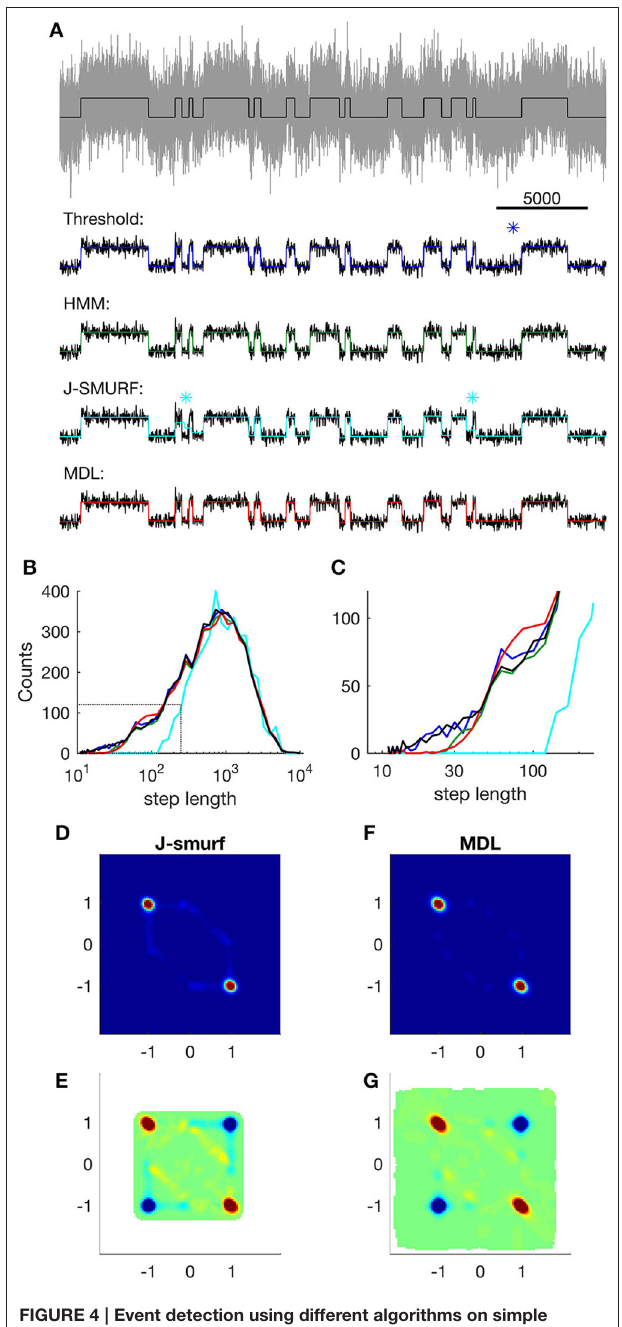
FIGURE 3 | Comparison of computation time for different datasets. SNR = 3.3; blue dots show mean and vertical lines show range between minimum and maximum from 10 iterations. SNR = 1; orange dots show mean and vertical lines show range from 10 iterations. SNR = 0 (uniform random data), yellow, single iteration. Example of scaling by Viterbi algorithm (SNR = 3.3); purple asterisk, single iteration. Black lines indicate O(N) (dashed) and O(N 2 ) scaling (solid).